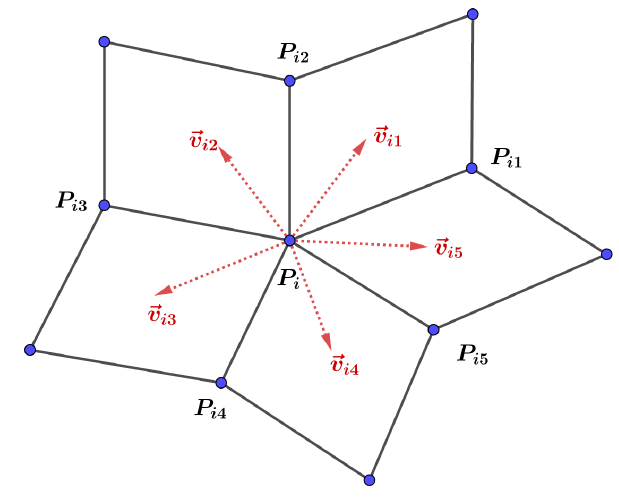
Figure 15. The normal vectors at the extraordinary point. (cid:3038) of the two vectors 𝑣⃑ The angle 𝜃 (cid:3036),(cid:3037)